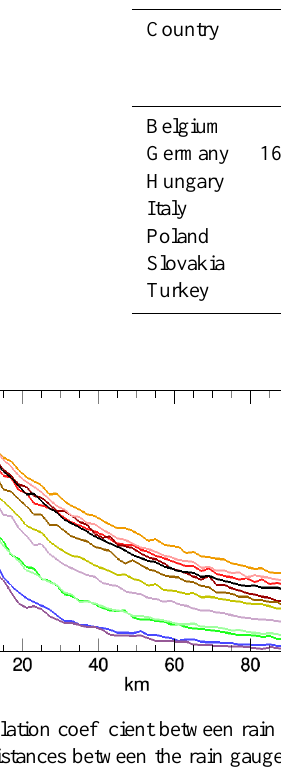
Table 4. Characteristics of the national radar networks.